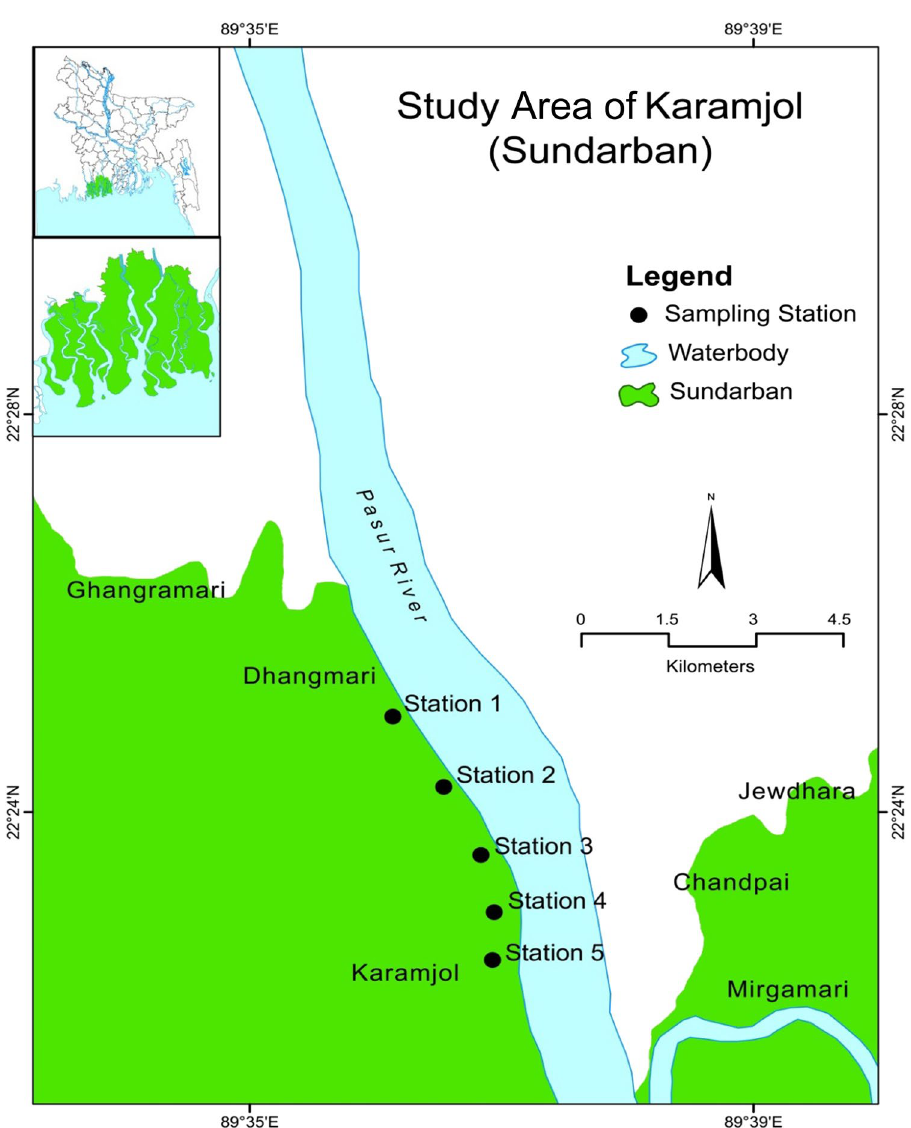
Fig. 1 Map of the study